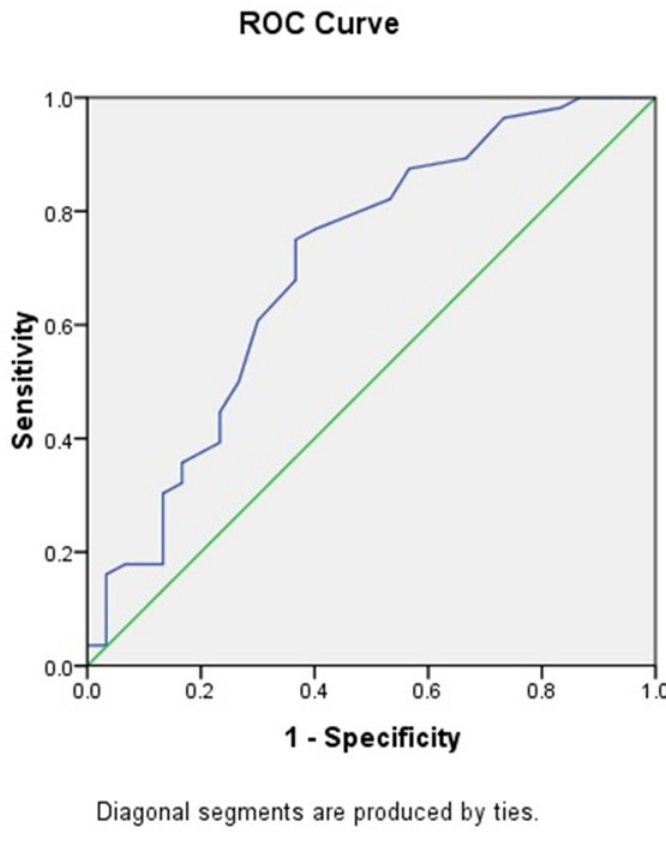
Fig 2. c-statistic (area under curve) =